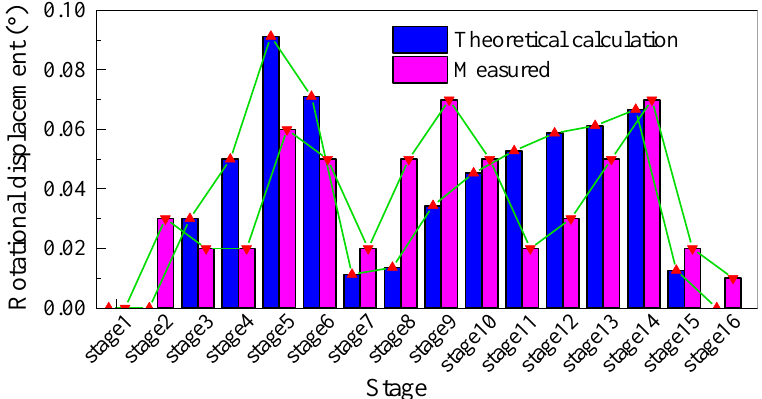
Figure 21. Comparison between theoretical and measured rotation angle of bridge tower.